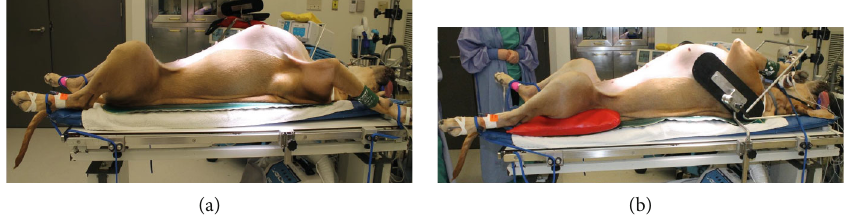
Figure 1: (a) An example of Great Dane in standard dorsal recumbency positioning prior to surgical procedure. (b) Note the additional supports and padding aimed at keeping the patient in the correct position without applying abnormal force to the